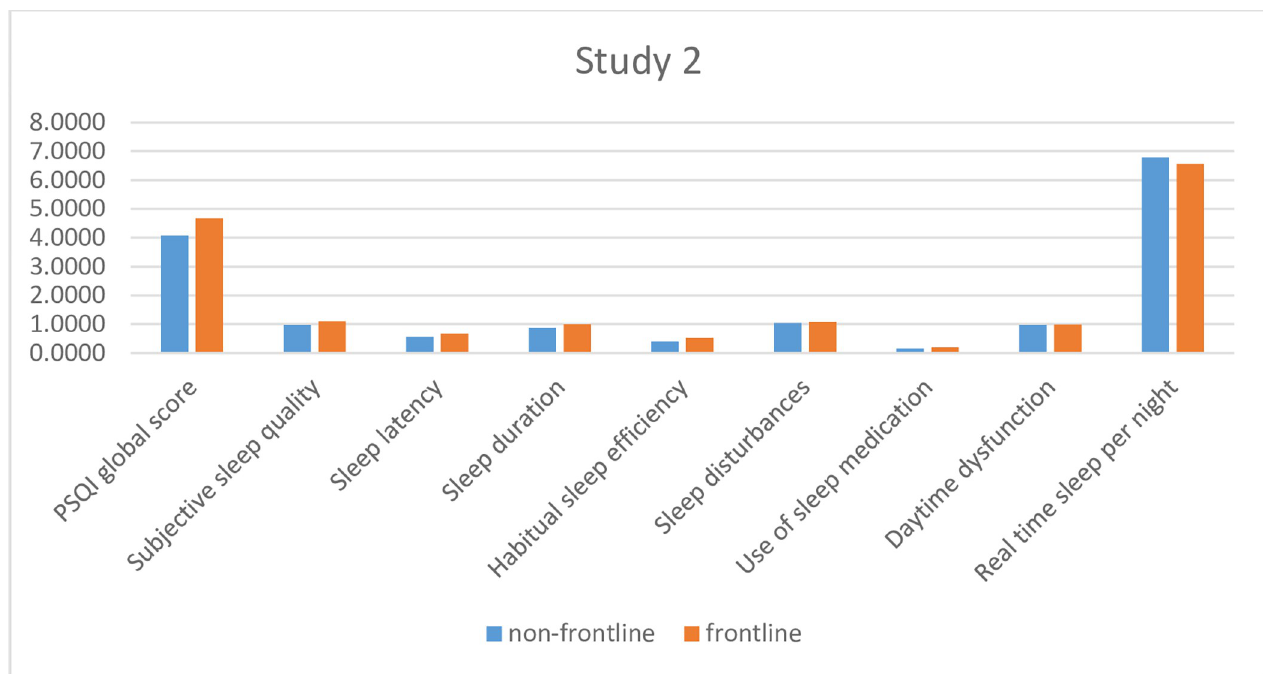
Fig 4. Individual components of PSQI after lossened